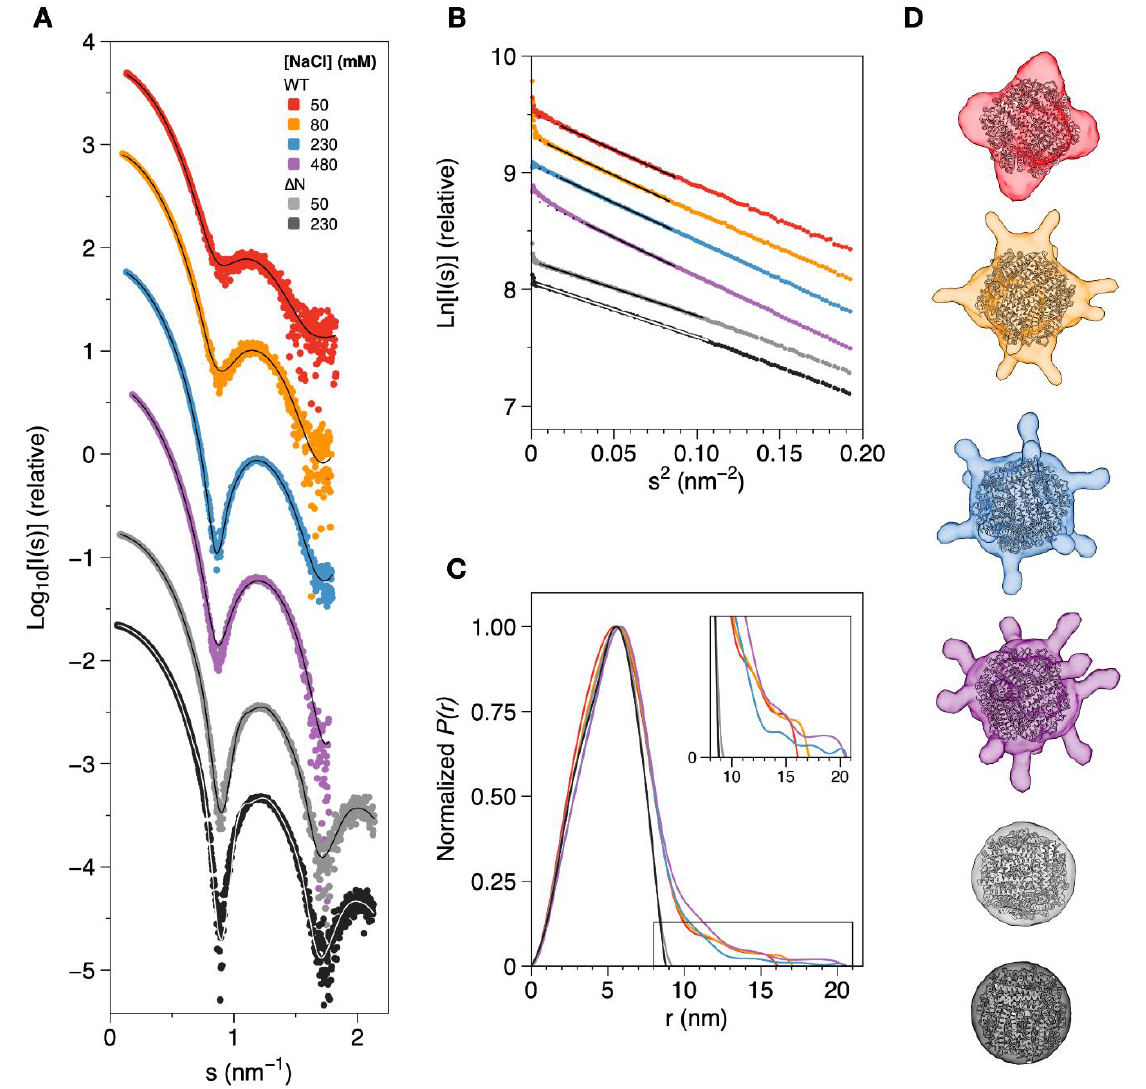
Figure 4. SAXS data and ab initio modelling of DgrDps WT and ∆ N variant in different ionic strength conditions. ( A ) Experimental scattering curves and calculated fits (solid lines) of DgrDps samples in 50 mM MOPS pH 7.0 buffer, containing varying NaCl concentrations, which are as follows: 50 mM (red), 80 mM (orange), 230 mM (blue) and 480 mM (purple) for DgrDps WT and either 50 mM (light gray) or 230 mM NaCl (dark grey) for the DgrDps ∆ N variant. ( B ) Guinier plots and linear fits (solid lines on top of the experimental points) of the scattering profiles shown in ( A ); ( C ) pair distance distribution curves; ( D ) representative ab initio models of DgrDps WT (generated by GASBOR) and ∆ N (generated by DAMMIN) in the different sample conditions tested, superimposed with the dodecamer model for each protein